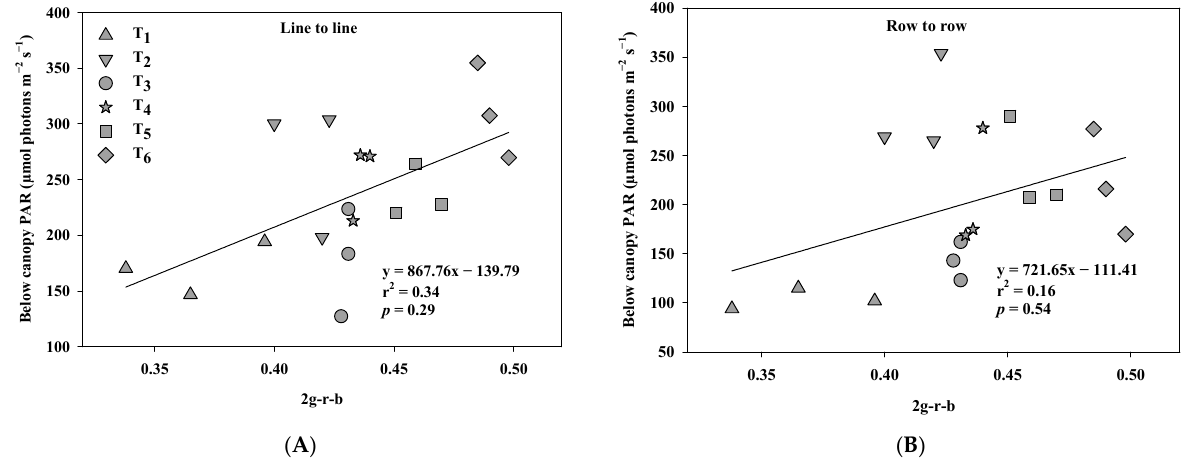
Figure 5. Relationship between below-canopy PAR and 2 g-r-b, line to line (panel ( A )) and row to row (panel ( B )). The PAR was measured between lines (panel A) and between rows (panel ( B )) since canopy coverage was different due to spacing (line to line = 60 cm and plant to plant = 20 cm for maize). Table 4. Canopy coverage and architecture analysis using camara-based vegetative indices (2g-red- b and VARI) for different treatments (Mean ± SE).